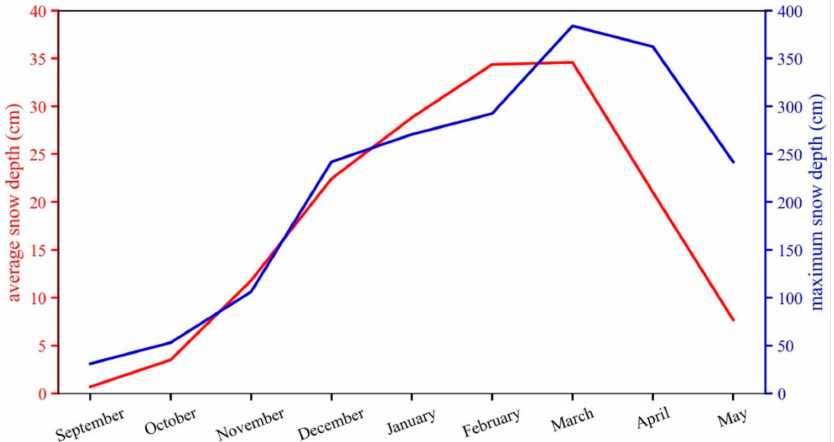
Figure 9. The average and maximum snow depth during the snow hydrology year from 2002 to 2011. Red line: monthly average snow depth; blue line: monthly maximum snow